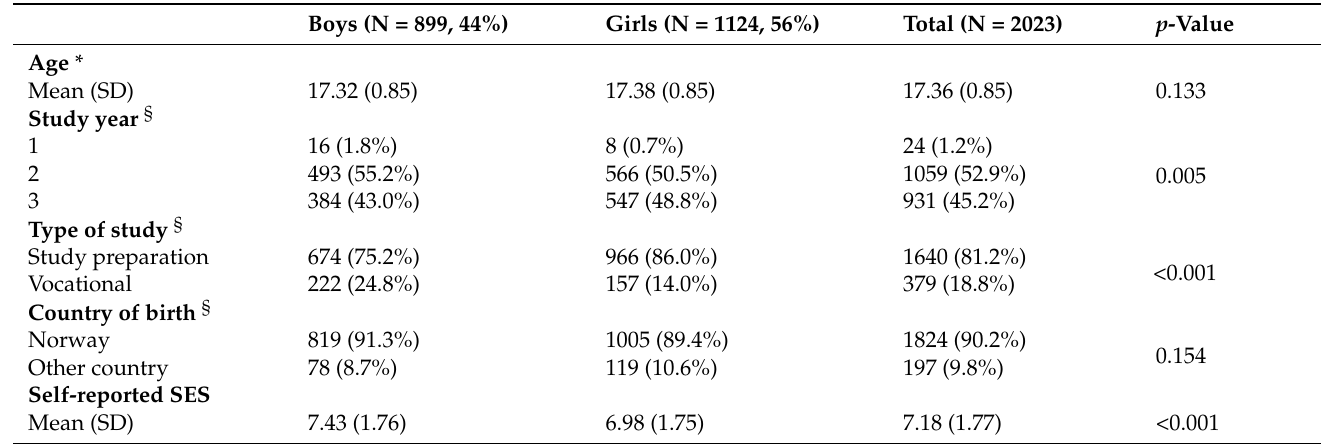
Table 1. Sociodemographic and background variables across gender. The p -values refer to differences between boys and girls.